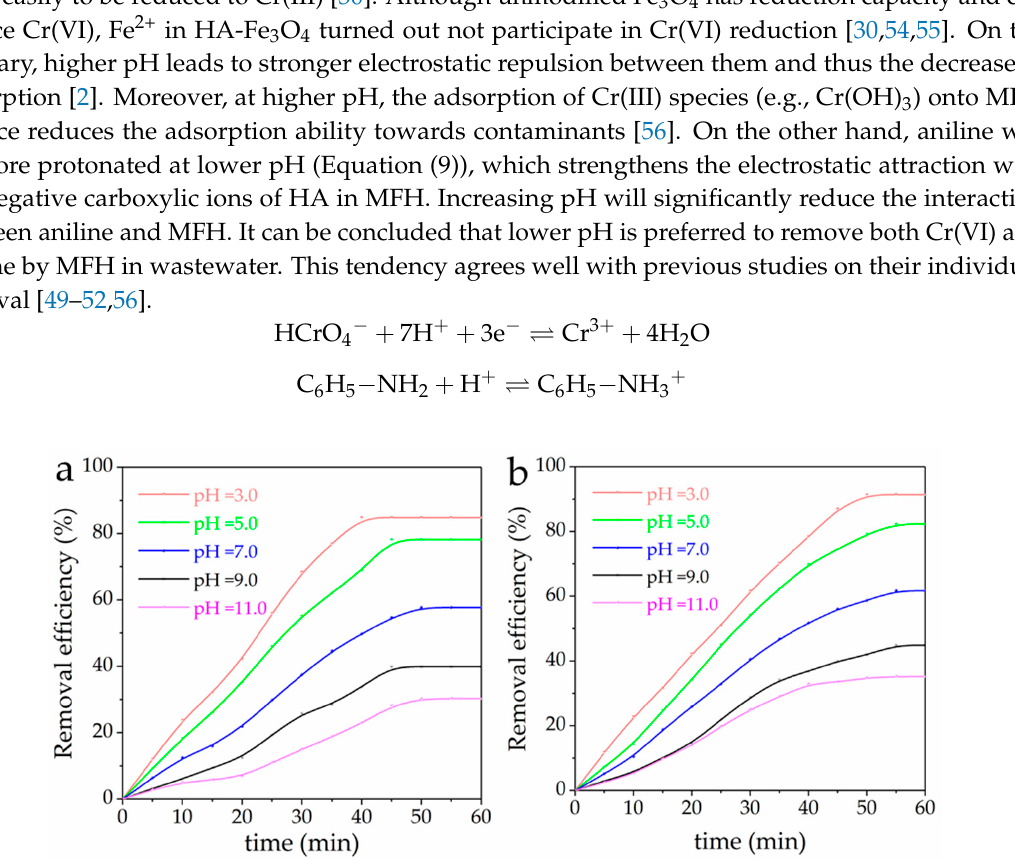
Figure 8. Simultaneously removing ( a ) Cr(VI) and ( b ) aniline at various MFH dosages. ( c 0 (Cr(VI)) = 40.0 mg·L − 1 , c 0 (aniline) = 100.0 mg·L − 1 , pH = 3.0, T = 25 °C). 3.7. Mutual Effect between Cr(VI) and Aniline Experiments were carried out to find whether Cr(VI) and aniline affected the removal of each other. As shown in Figure 9, when c 0 (aniline) and c 0 (Cr(VI)) were increased from 0 to 200 mg·L − 1 and 0 to 100 mg·L − 1 respectively, their corresponding removal efficiency barely improved. Since the upper limits of their initial concentrations were relatively high compared with actual wastewater, it can be assumed that they have no remarkable influence on the adsorption of each other by MFH. It is most likely that they are adsorbed by MFH in different mechanisms (Cr(VI), Langmuir, pseudo first-order kinetic; aniline, Freundlich, pseudo second-order kinetic), and the adsorption force is much stronger than the interaction between them.